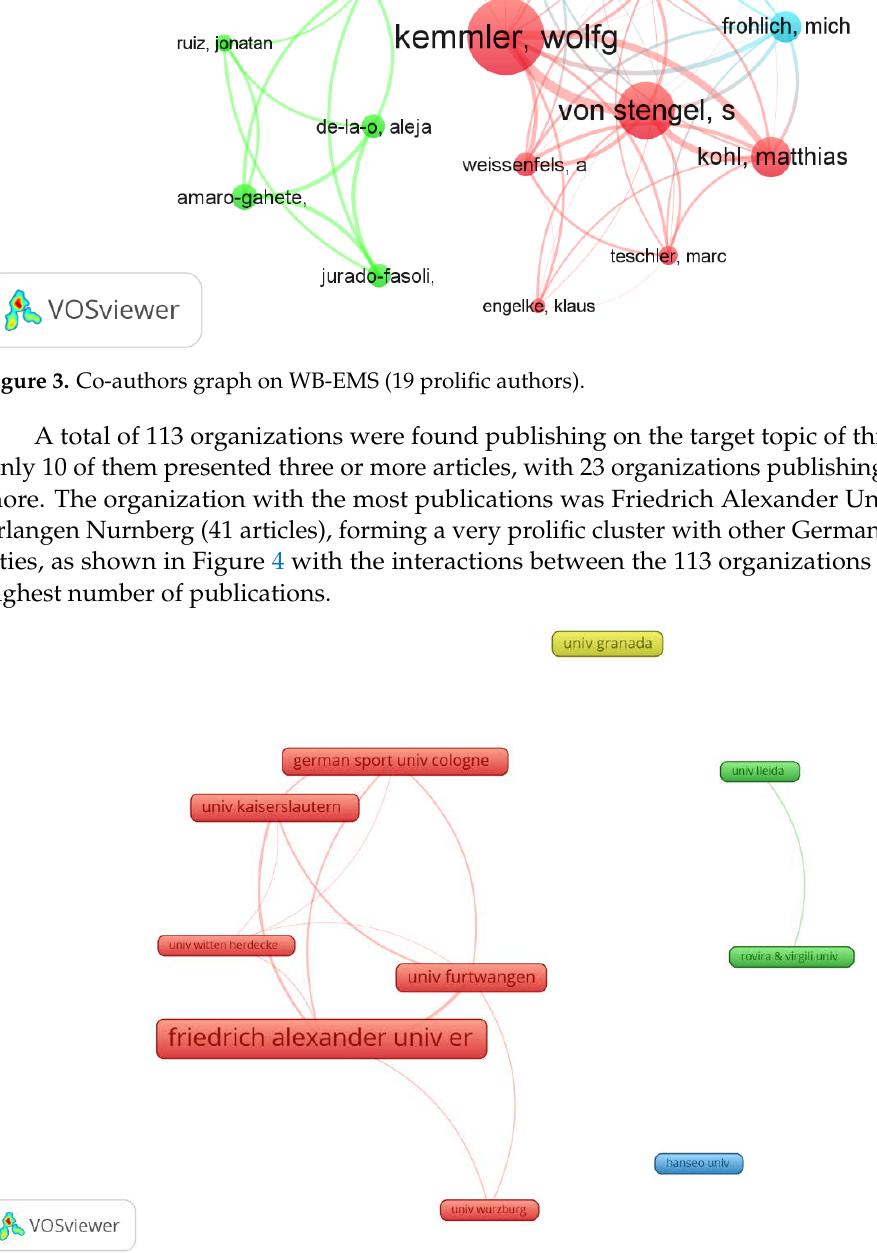
Figure 4. Graph of prolific organizational co-authors on WB-EMS.